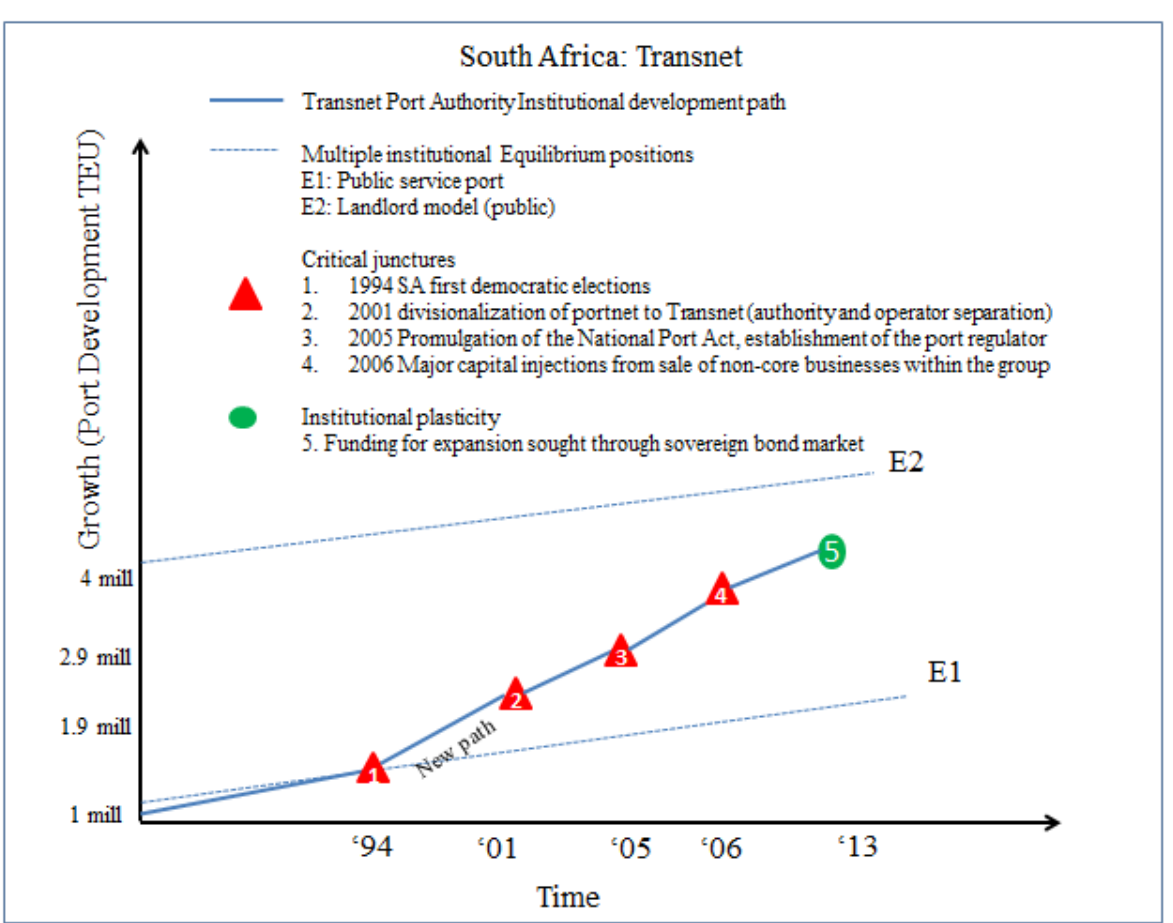
Figure 5. Institutional development path of South